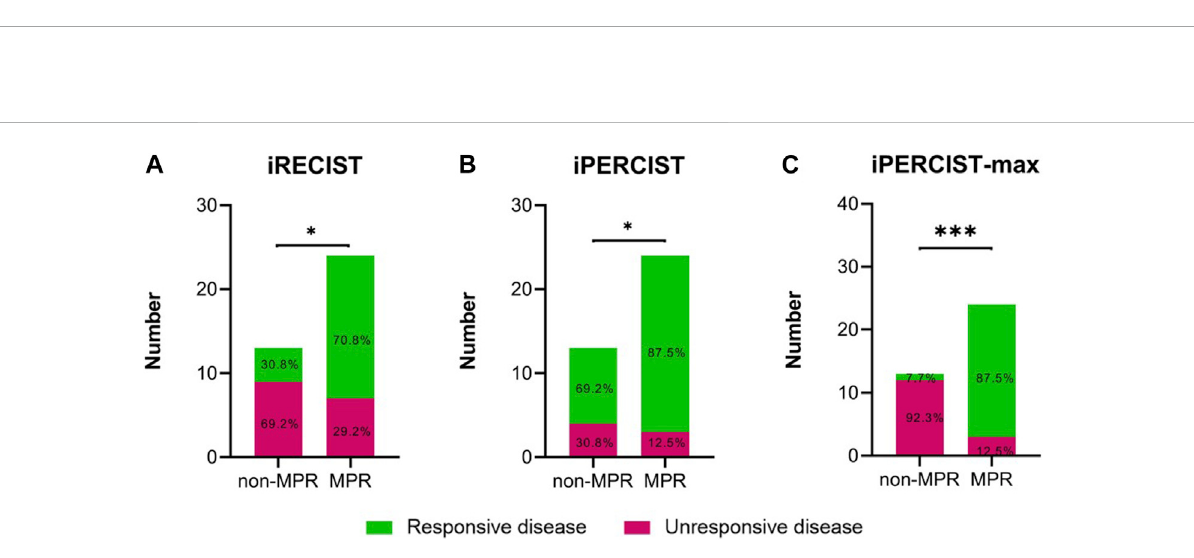
FIGURE 3 Differences in radiological disease responsiveness between mPR and non-mPR status based on iRECIST/iPERCIST/iPERCIST-max. (A) iRECIST; (B) iPERCIST; (C) iPERCIST-max. Green color represents responsive disease, while red color represents unresponsive